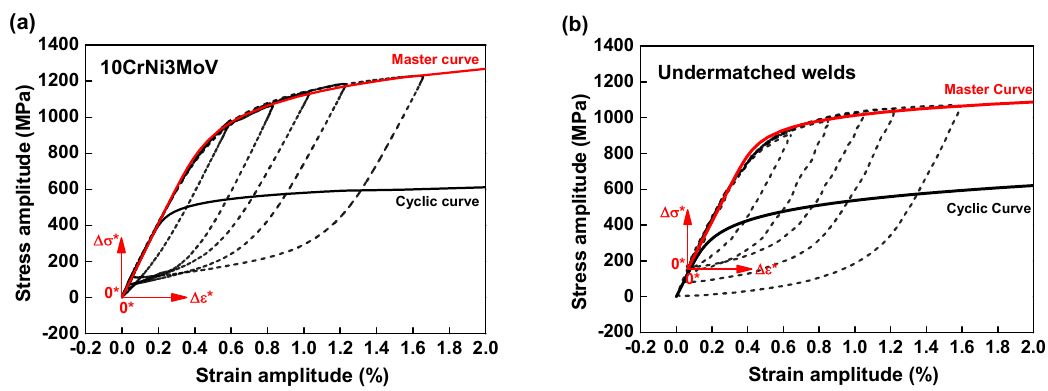
Figure 8. Superposition of the stable hysteresis loops at half-life along the linear portion to match upper branches, and corresponding master curves: ( a ) 10CrNi3MoV steel; ( b ) Undermatched welds.